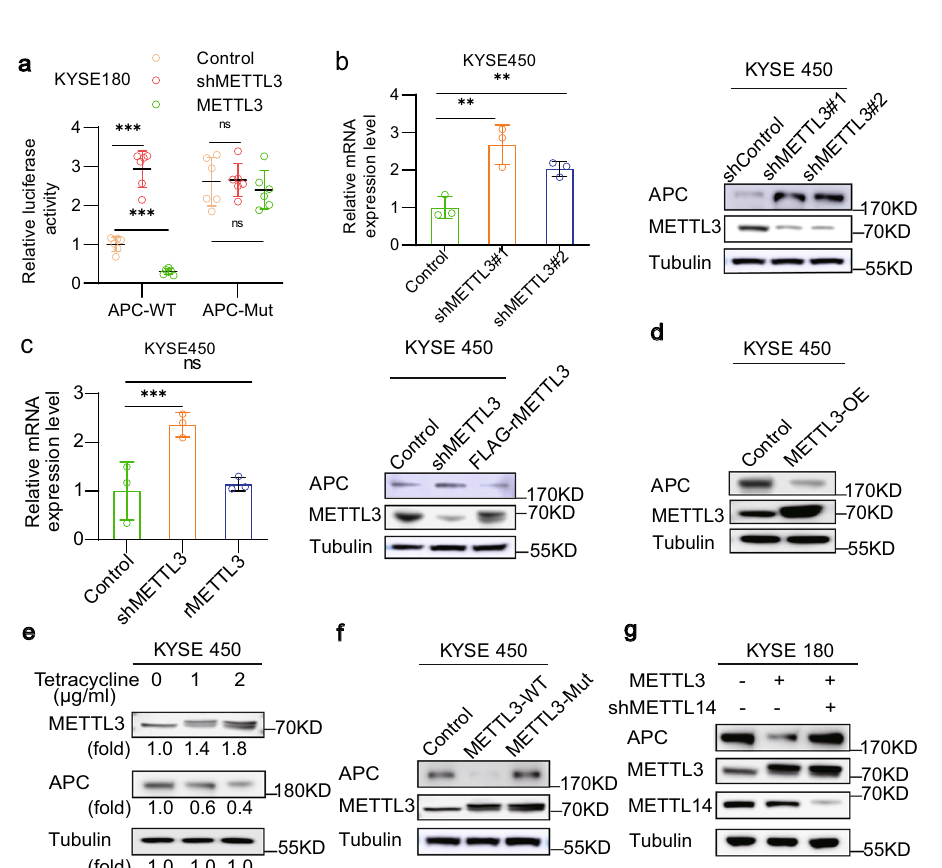
Fig. 4 METTL3-dependent m 6 A upregulation on APC mRNA suppresses APC expression. a Luciferase vectors with the WT or mutated m 6 A nucleotides in the APC gene were transfected into KYSE180 cells with or without METTL3 depletion or METTL3 overexpression. Relative luciferase activity was measured. Data represent means ± SD of triplicate samples. *** p = 2.93E − 06 (left), 5.88E − 06 (right). Two-tailed t -test; ns, not signi fi cant. b , c The relative mRNA and protein expression levels of APC in KYSE450 cells with or without METTL3 depletion ( b ), or with reconstituted expression of Flag- rMETTL3 ( c ) were determined by qPCR and immunoblotting analyses with the indicated antibodies, respectively. Data represent means ± SD of triplicate samples. b ** p = 0.0088 (left), 0.0074 (right). c *** p = 0.0004. Two-tailed t -test; ns, not signi fi cant. d – g KYSE450 cells were transfected with or without a plasmid expressing METTL3 ( d ). KYSE450 cells expressing the METTL3 expression-inducible Tet-on lentiviral vector were treated with or without the indicated dosages of tetracycline e . KYSE450 cells were transfected with or without plasmids expressing WT METTL3, an inactive METTL3 mutant ( f ), WT METTL3 or METTL3 and METTL14 shRNA ( g ). Immunoblotting analyses were performed for three times with similar results. Source data are provided as a Source Data fi